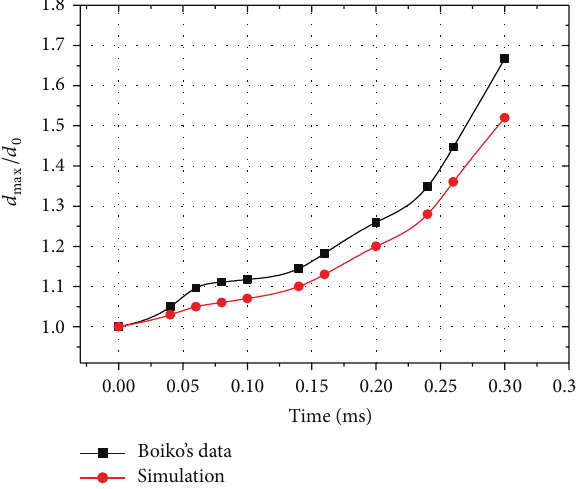
Figure 13: Comparison of numerical results with experimental data [20].